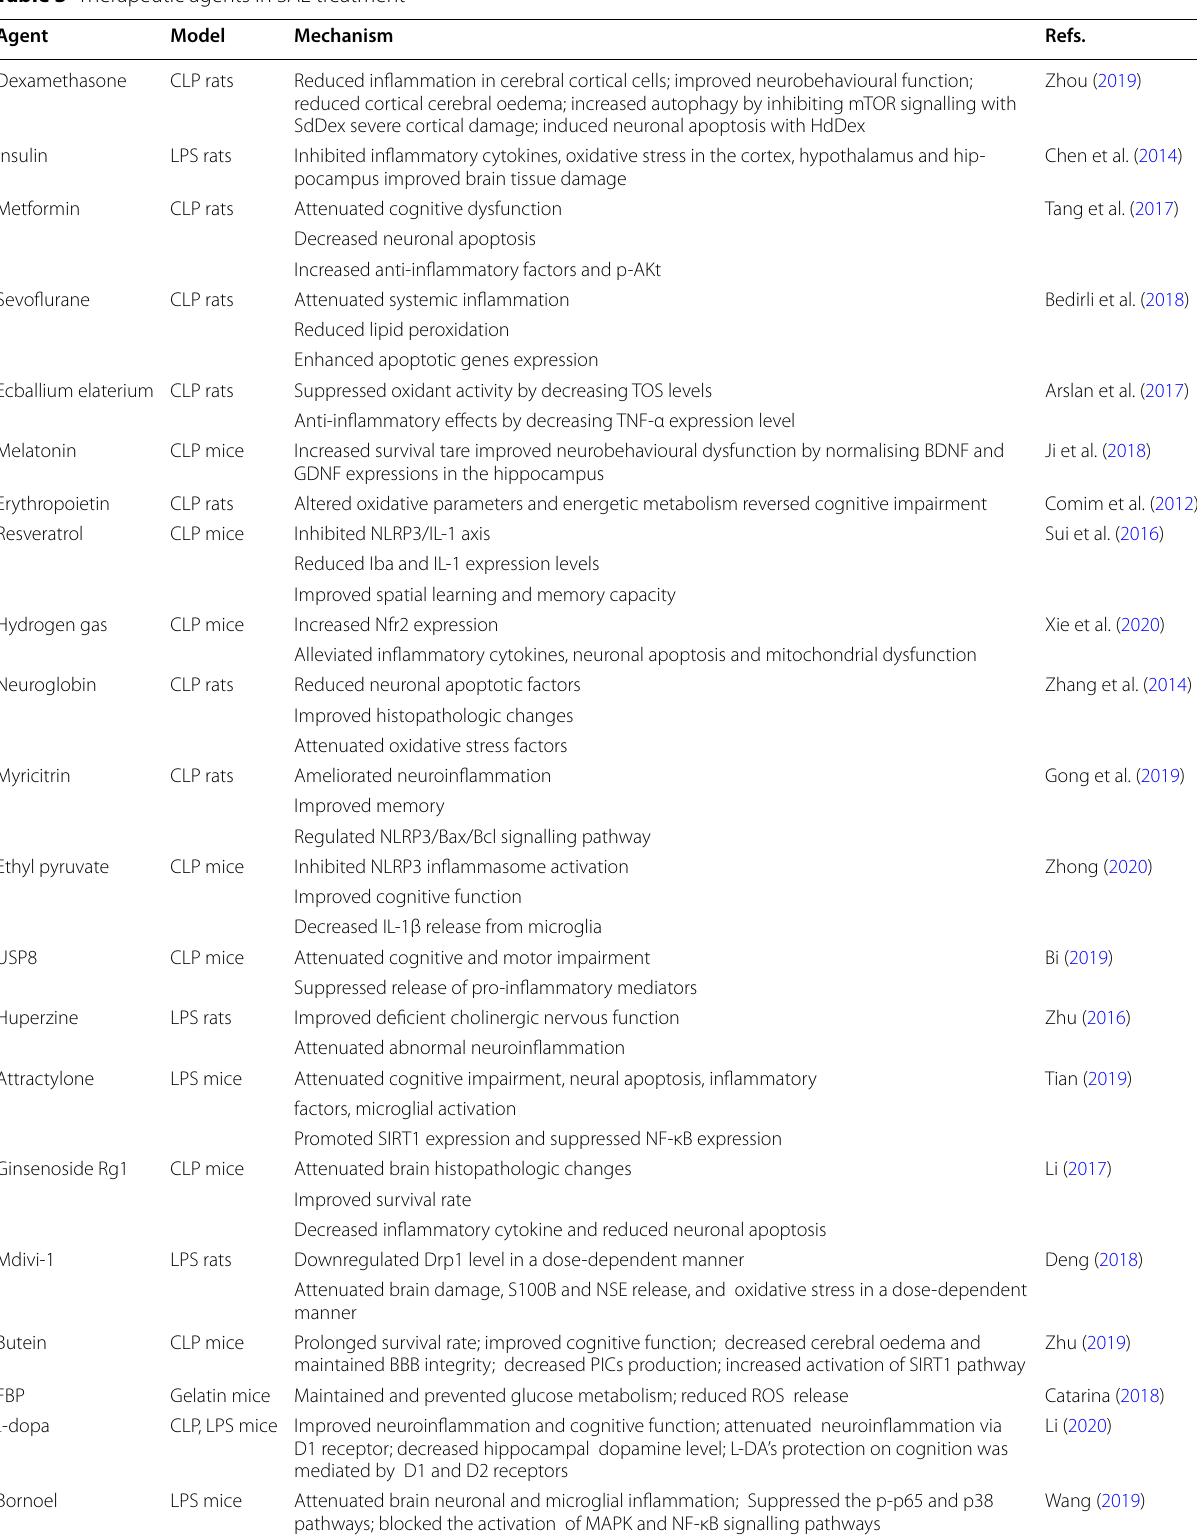
Table 3 Therapeutic agents in SAE treatment